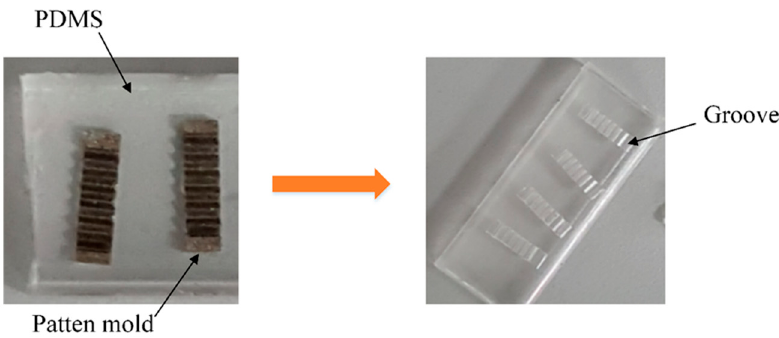
Figure 3. Fabrication of PDMS cell-holding device with stainless steel mold.